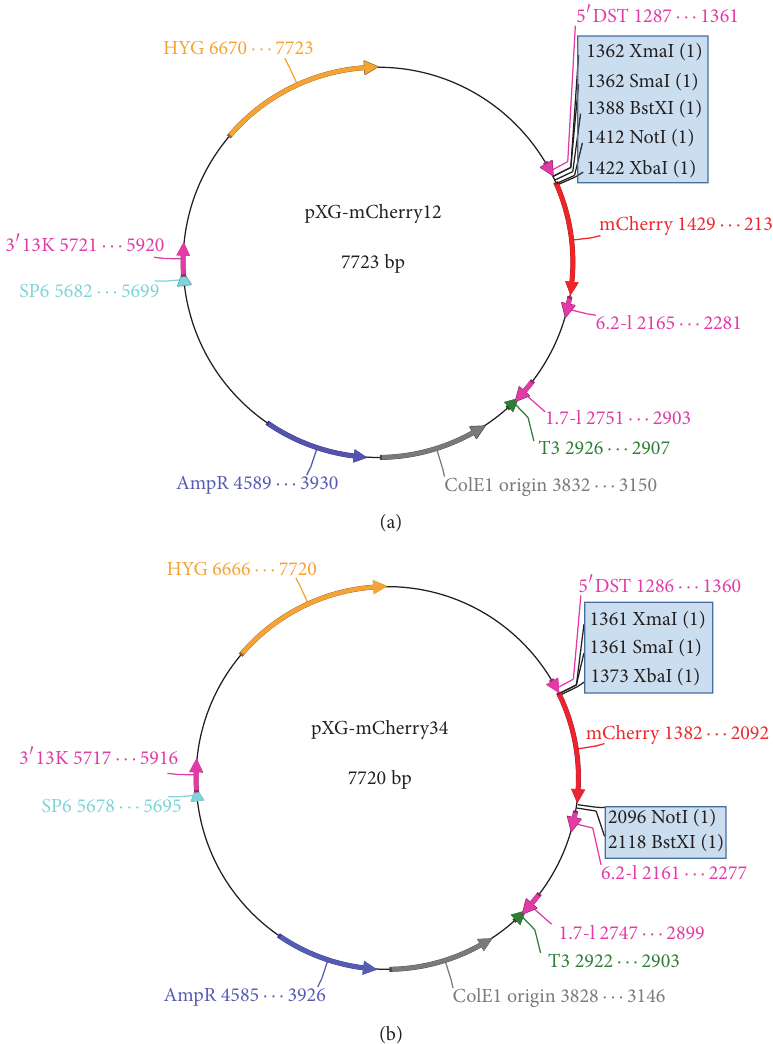
Figure 1: Schematic representation of pXG-mCherry plasmid constructs. (a) pXG-mCherry12. (b) pXG-mCherry34. HYG, hygromycin B phosphotransferase gene. Blue boxes depict the polylinker sequences (MCS: multiple cloning site). Vector map representation was implemented using ApE v2.0.48